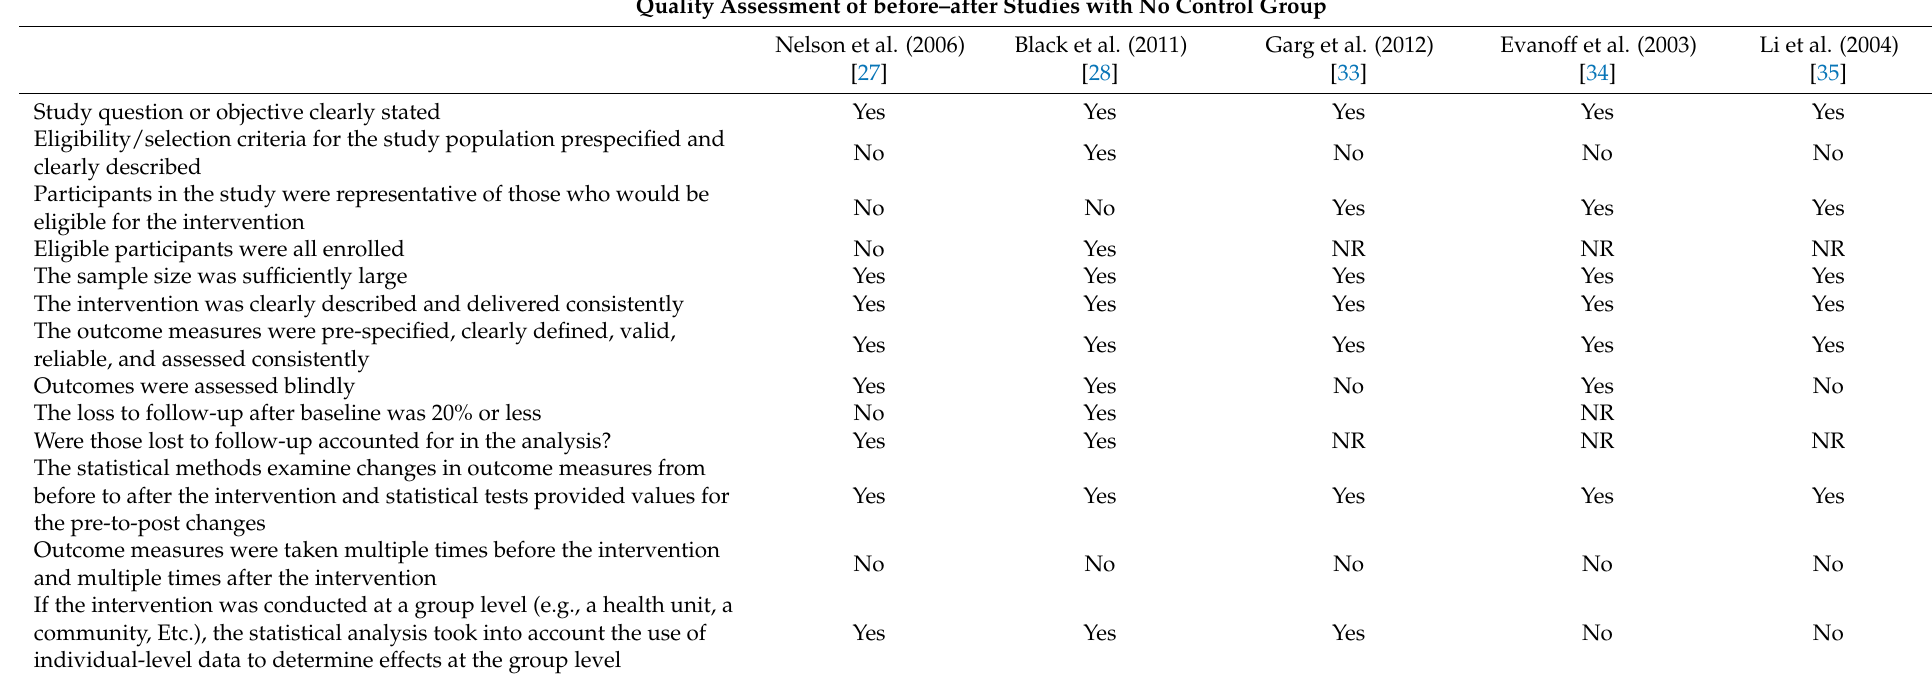
Table 4. Quality assessment of before–after studies with no control